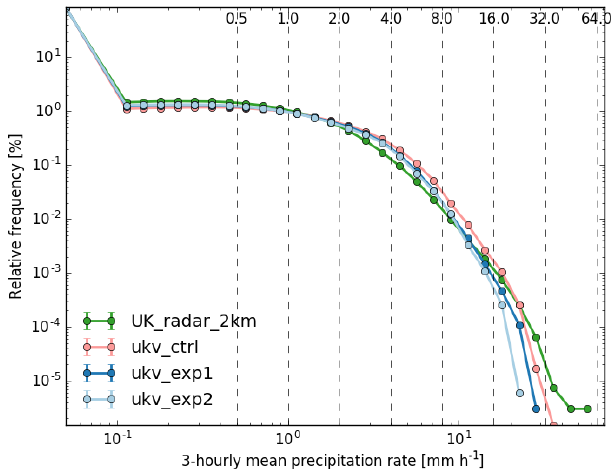
Figure 8. Case studies: diurnal cycle of 10m wind mean vec- tor magnitude error (a) and root mean square vector error (b) for 12:00Z forecasts. RAL0 (red) and RAL1-M (blue).